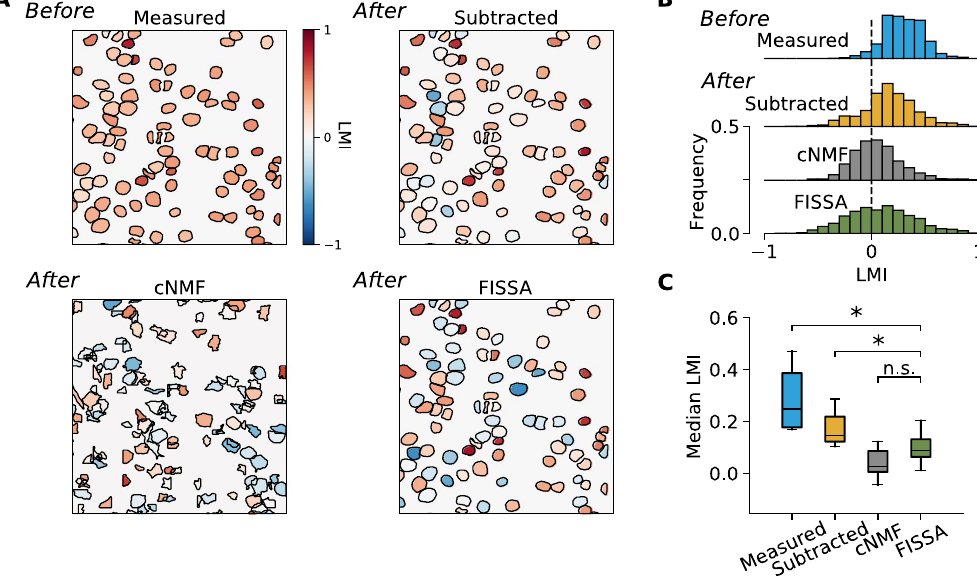
Figure 5. Impact of neuropil decontamination on neuronal responses measured with two-photon calcium imaging, in V1 layer 2/3 of awake behaving mice. Neurons were labelled with GCaMP6f 4 . The effect of locomotion was quantified for each neuron by the locomotion modulation index (LMI). ( A ) An example field of view with somatic ROIs coloured by the LMI value obtained either before neuropil decontamination (‘Measured’) or after decontamination. The ROIs for the measured, subtraction, and FISSA methods are identical and were defined by hand. For the cNMF method the ROIs are presented as detected by the algorithm. LMI values were calculated for periods of visual stimulation with oriented gratings (10 to 20 trials per field of view, 60 s/trial). ( B ) The distributions of LMI values across all layer 2/3 cells in eight mice, before (‘Measured’) and after each decontamination method. ( C ) The distributions of median LMI values for the eight mice, before and after decontamination. * p < 0.05; n.s.: not significant (p > 0.05); Wilcoxon signed-rank test, n = 8 mice, FISSA vs measured: p = 0.0117, FISSA vs subtraction p = 0.0117, FISSA vs cNMF p = 0.0687, subtraction vs cNMF p =